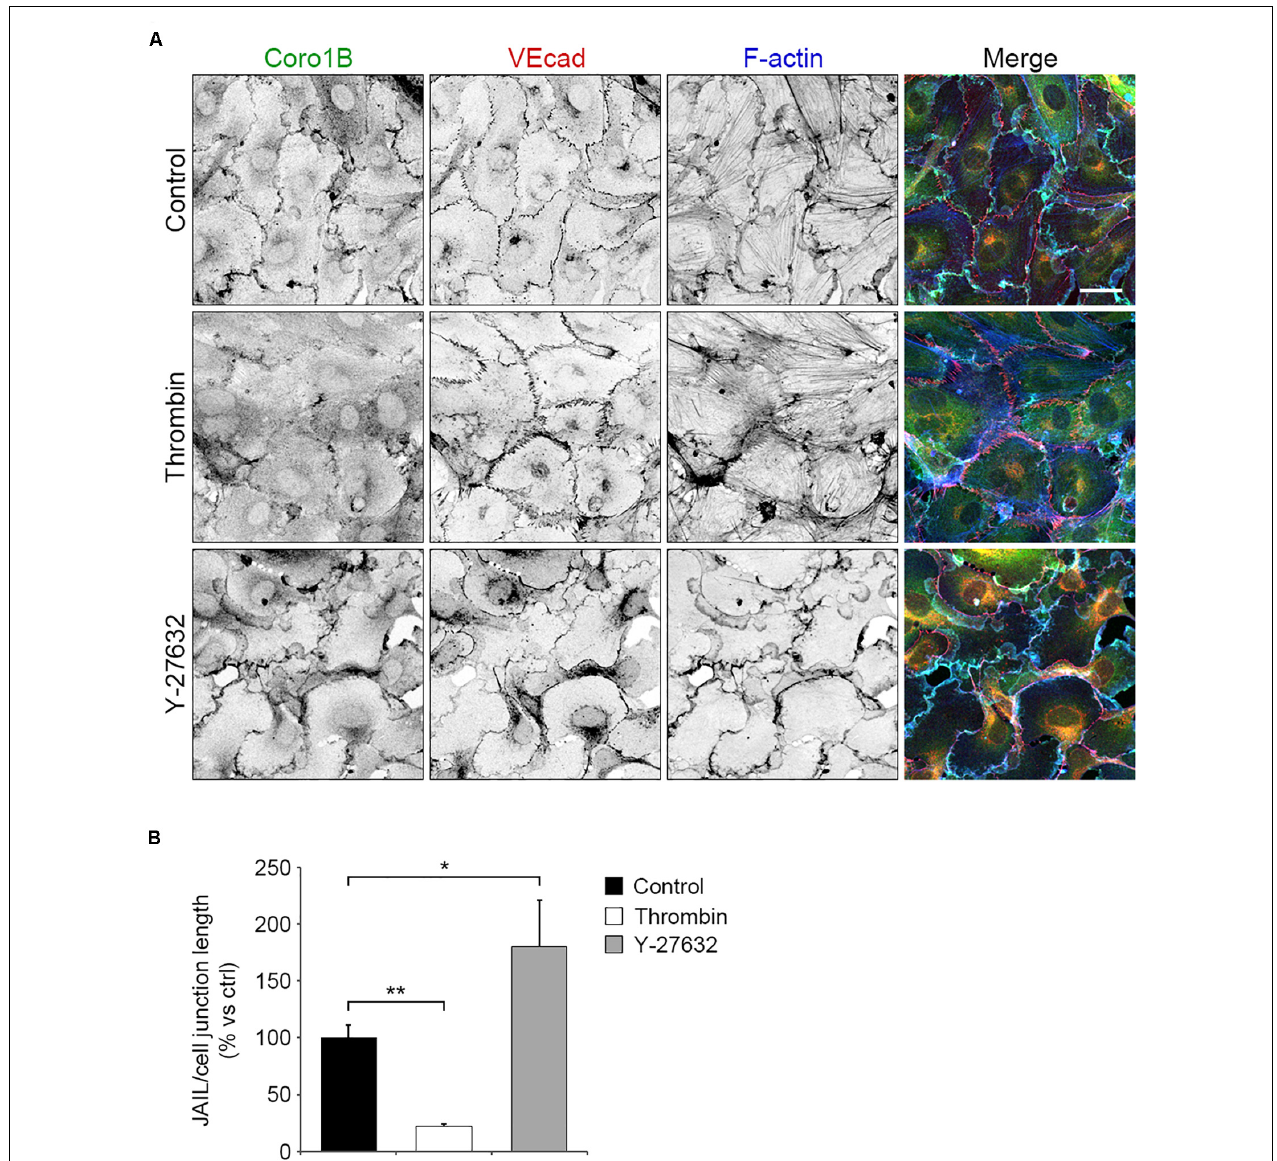
FIGURE 3 | Coro1B localization at cell–cell junctions is regulated by actomyosin contraction. (A) HUVECs untreated (control) and treated with thrombin (0.2 U/ml) or Y-27632 (10 µ M) and immunostained for Coro1B (green), VEcad (red) and F-actin (blue). Scale bar = 25 µ m. (B) Quantitative analysis of JAIL number per cell–cell junction length in control and treated cells. Data represent mean ± SD. * P < 0.05, ** P < 0.01. n =